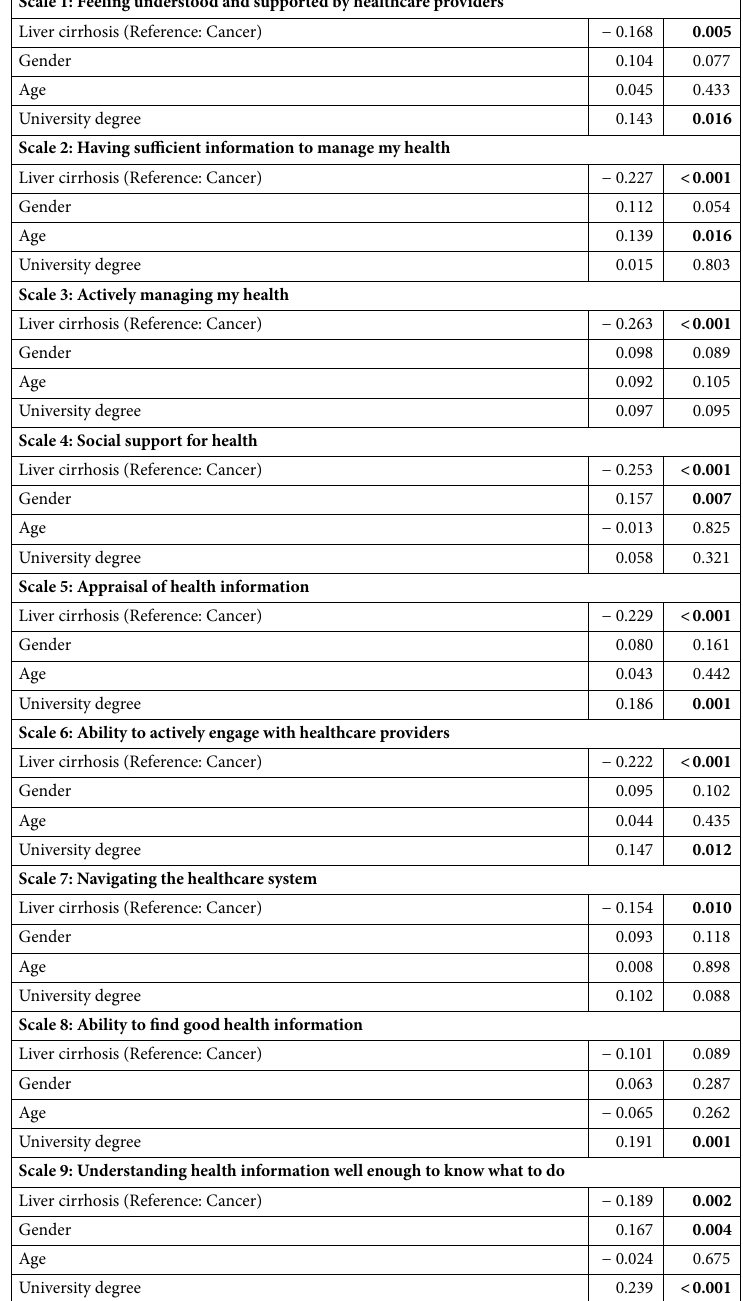
Table 2. Multivariable linear regression analyses of each subscale of the HLQ comparing patients with liver cirrhosis and cancer. Significant values are in [bold]. Cancer was coded as 1 and liver cirrhosis was coded as 2. Gender: men were coded as 1 and women as 2. University degree was coded as 1 and no university degree was coded as